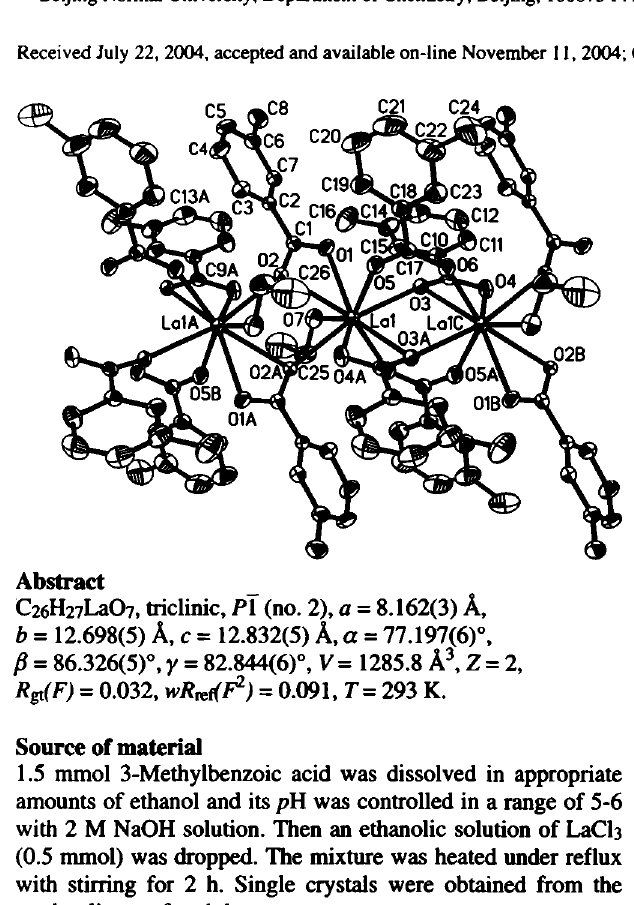
Table 1. Data collection and handling.